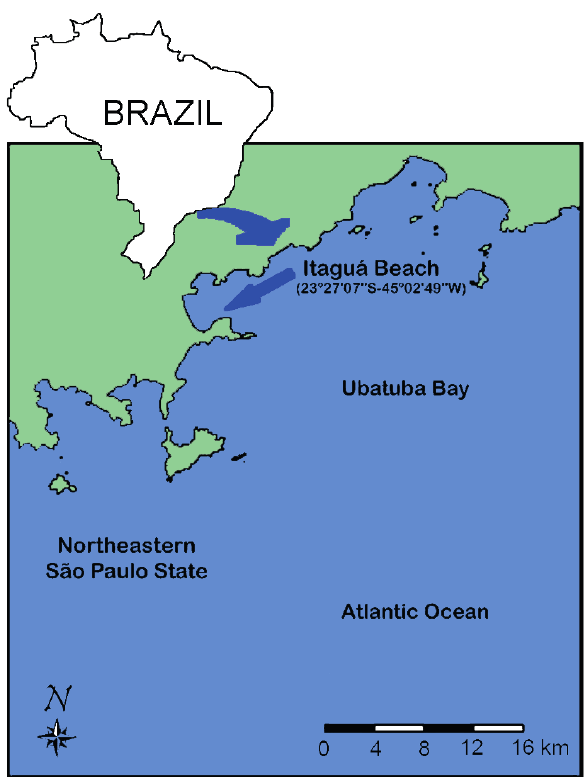
Figure 1. Northeastern coast of São Paulo, Ubatuba Bay; arrow points out Itaguá Beach,